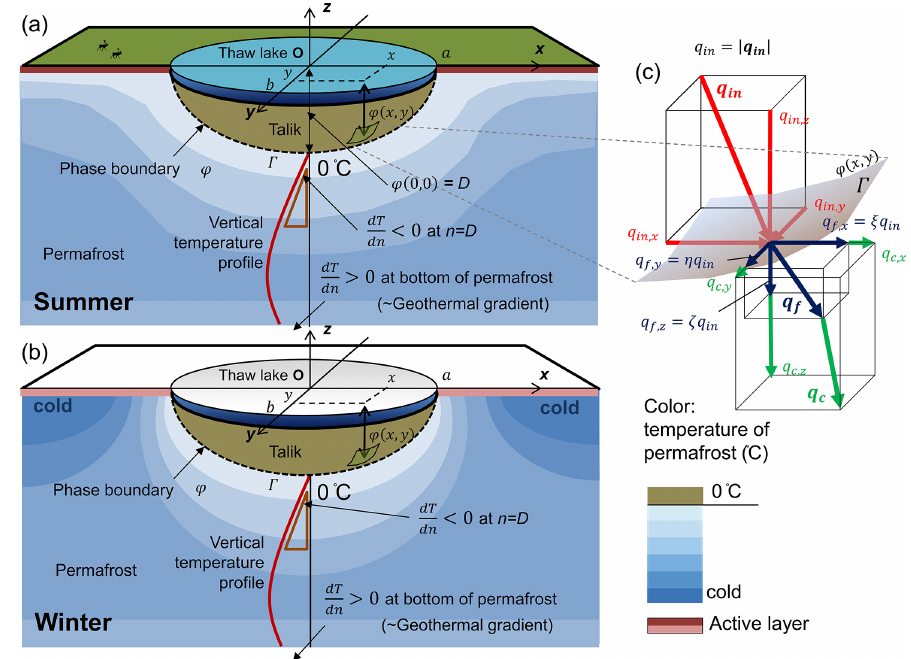
Figure 1. Definitions of variables associated with the overall shape of phase boundary ϕ during warm (a) and cold seasons (b) and incoming and outgoing heat transfers on ϕ(x,y) (c) . Incoming heat (red-colored vector) is perpendicular to the phase boundary ϕ(x,y) , while thaw direction (blue-colored vector) is modified by the anisotropic heat conduction (green-colored vector) in the